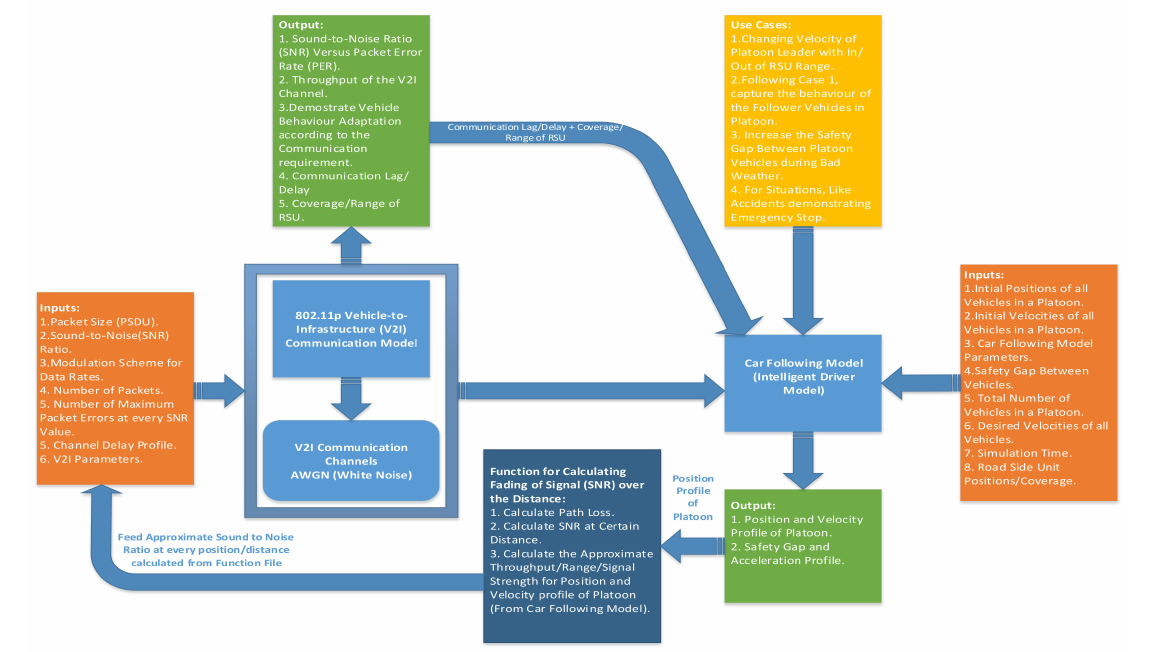
Figure 4. Integration of IDM and 802.11p V2I communication in